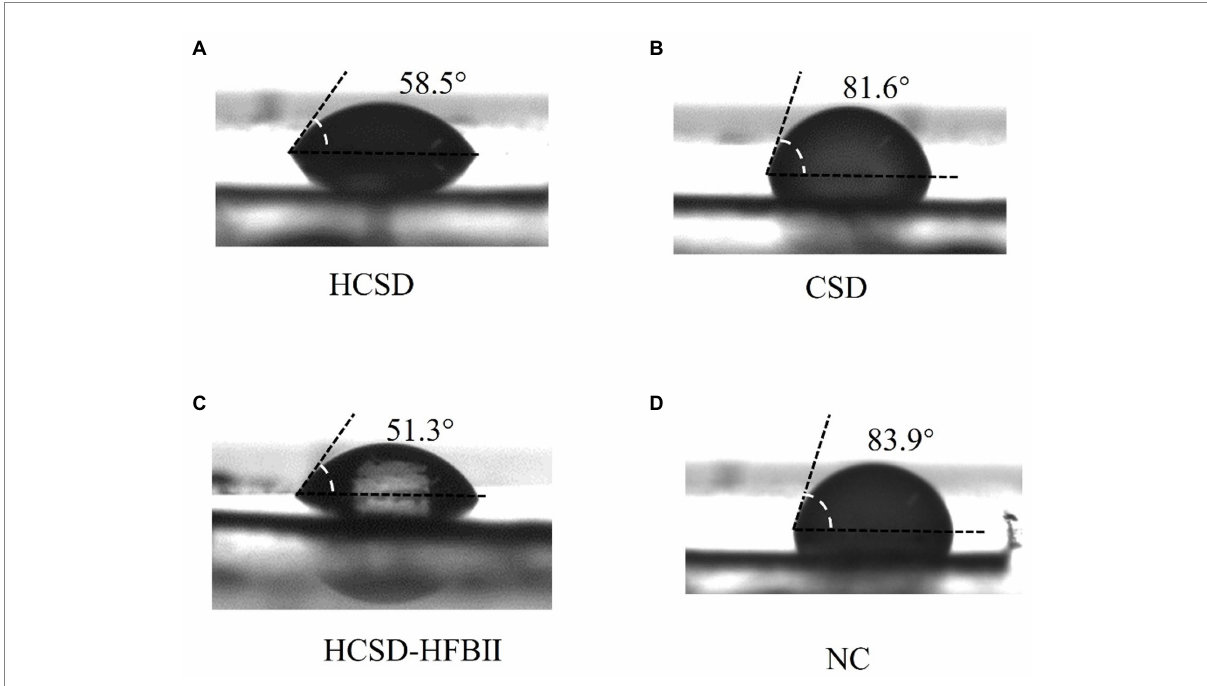
FIGURE 5 Surface tension analysis of E. coli harboring HCSD (A) , CSD (B) and HCSD-HFBII (C) with OD 600 of 3 in LB medium of non-pretreated PET surface, E. coli without any expression plasmids (D) as a negative control.